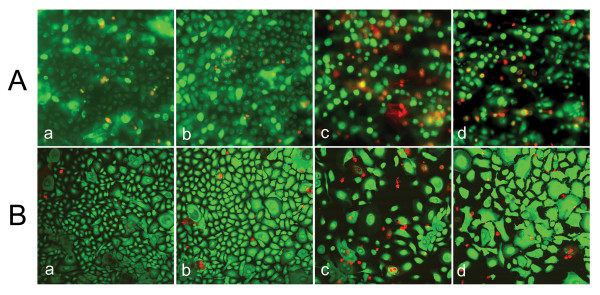
Anti-cytotoxicity effect of roxithromycin on SM-treated SAE and BTE cells. Cell viability was examined by Calcein AM/EthD-1 fluorescence staining 24 h after exposure. The images for SAE cells (A) were captured by fluorescence microscopy whereas those for BTE cells (B) by confocal fluorescence microscopy. a) control (unexposed), b) 100 μM roxithromycin, c) 100 μM SM, and d) 100 μM SM + 100 μM roxithromycin. Cells stained green were alive and those stained red dead.